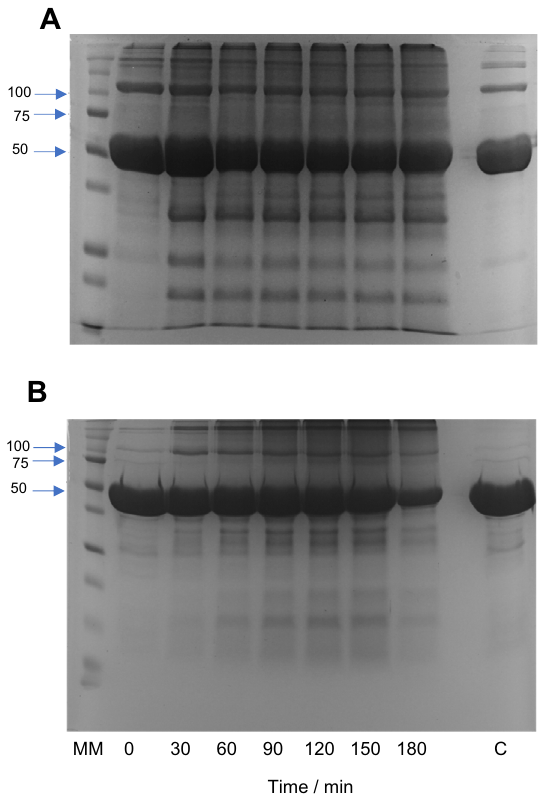
• Figure 3. Oxidation of G6PDH and 6PGDH mediated by AAPH-derived ROO affects the molecular mass of the proteins and generates aggregates and fragments. Solutions of G6PDH (54 μM monomer) or 6PGDH (58 μM monomer) were incubated in the absence and presence of 100 mM AAPH at 37ºC in 75 mM phosphate buffer, pH 7.4. Aliquots of these solutions were taken every 30 min up to 180 min, AAPH removed as described in the Materials and methods, and samples kept at -80ºC until subjected to electrophoresis analysis. Panel A and B present SDS-PAGE of G6PDH and 6PGDH, respectively. SDS–PAGE was run under reducing conditions on 4–12% Bis–Tris acrylamide gels with 60 μg of protein loaded per well. MM: molecular mass markers, with masses indicated on left hand vertical axis. Lane C shows the electrophoretic pattern of proteins incubated for 180 min in the absence of